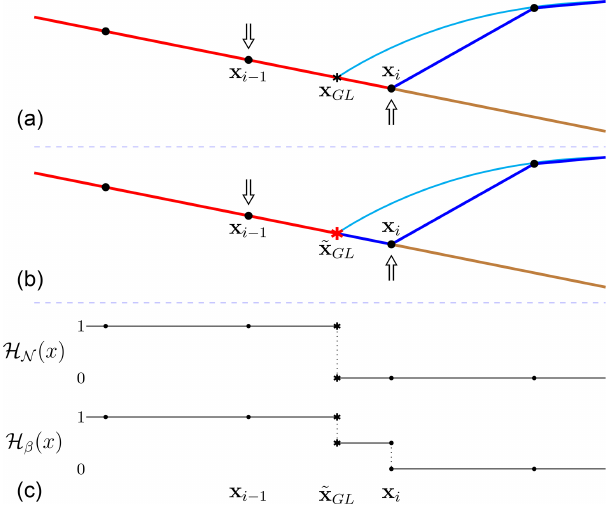
Figure 2. Schematic figure of the GL in case i, with the arrows indicating the direction of the net forces in the vertical direction. The light blue line is the analytical solution of the ice sheet with the analytical GL position x GL . The red line is the grounded boundary (cid:48) bg , the dark blue line is the floating boundary (cid:48) bf , and the brown line is the bedrock topography b(x) . (a) The last grounded and first floating nodes as defined in Elmer/ICE. (b) Linear interpolation to approximate the numerical GL position ˜ x GL . (c) The step functions H N (x) and H β (x) indicate the area for Nitsche’s penalty and slip boundary